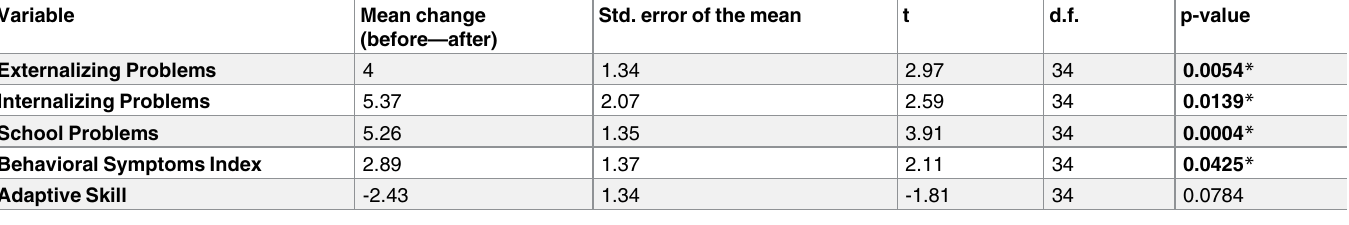
Table 2. Student’s paired t-test of the averagedifference in BASC-2T scores from before MDA treatment to after treatment for all participating stu- dents (N = 35). Variable Mean change Std. error of the mean t d.f. p-value (before—after)